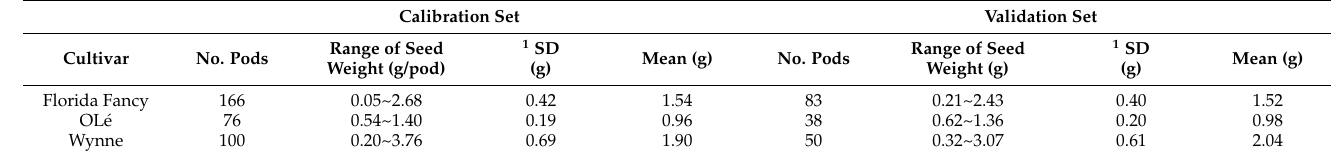
Table 1. Number of pods and seed weights for the cultivars used in model calibration and verification.